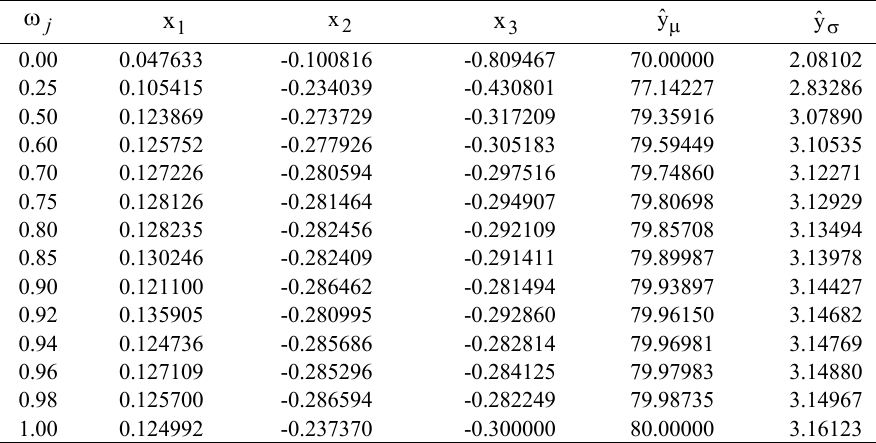
Table 2. Final results from the optimization